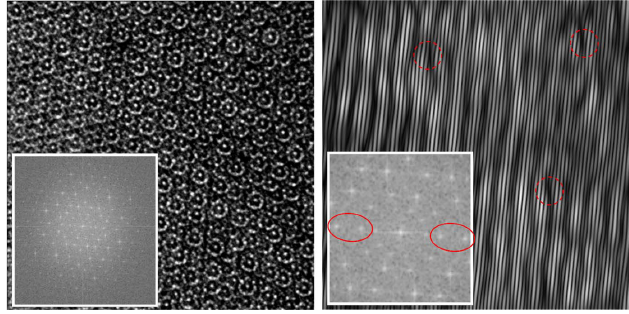
Figure 4 600 (cid:7) 600 px HRTEM image and its Fourier transform (inset in left image) presented in log scale. The inverse Fourier transform for the co- linear peaks of the reciprocal space, encircled with a red continuous line in the inset (right) magnified Fourier transform, was calculated in order to show the Ammann lines. (Right) Image shows wavy lines indicating the phonon strain. A few instances of dark patches are marked with red dotted circles. The line pattern is continuous on both sides of the black area hence there is no jag that can be ascribed to linear phason strain.